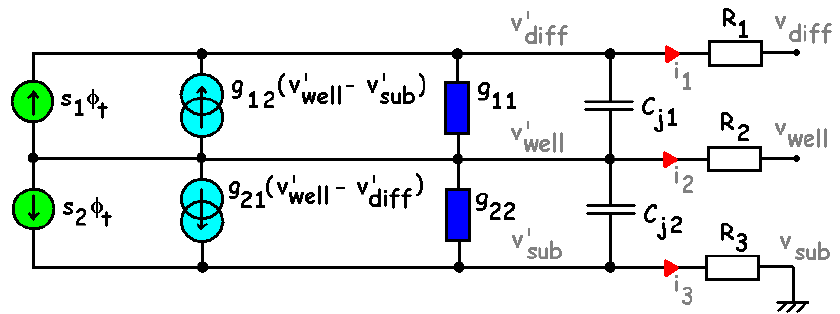
Figure 12. Small-signal equivalent circuit of the BDJ